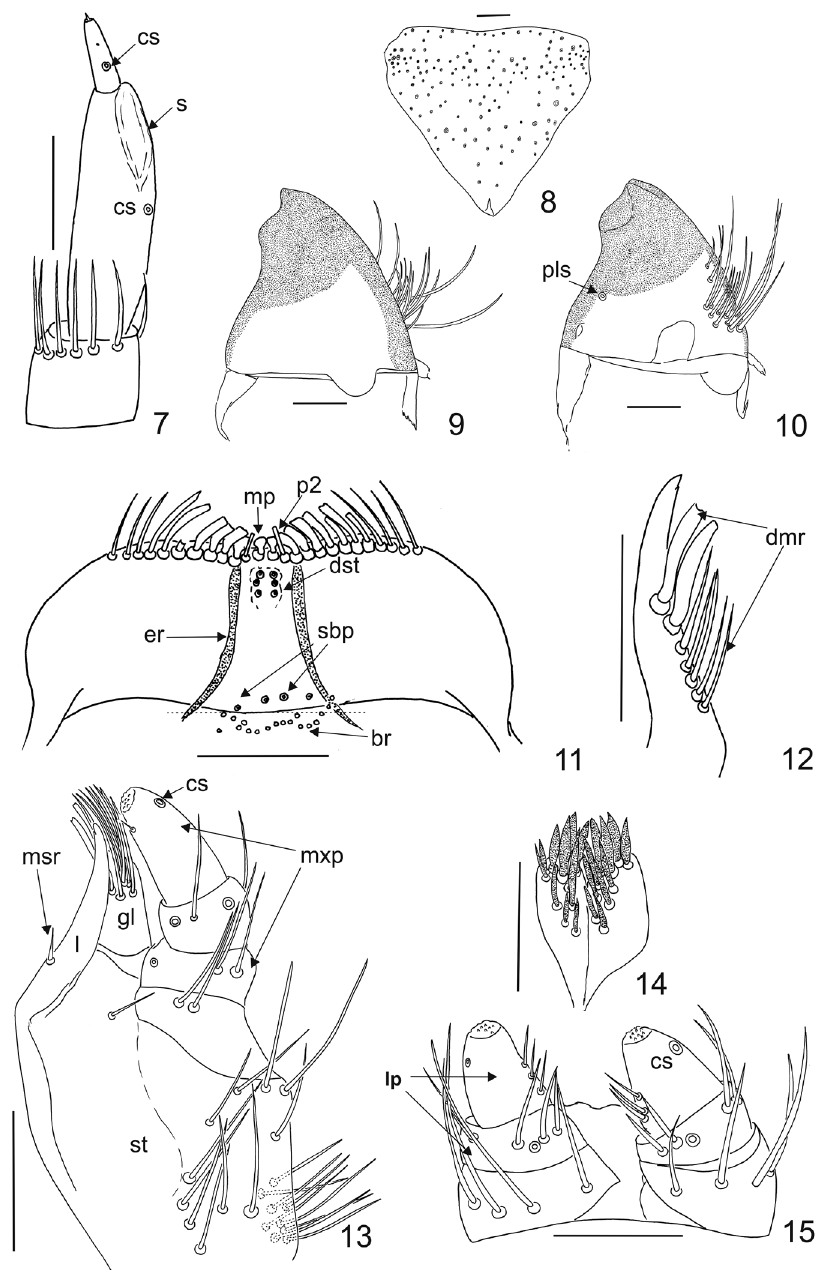
Figures 7–15. Mature larva of Ctesias (s. str.) serra (Fabricius, 1792). 7 Antenna (dorso-fronto-lateral) 8 Frons (dorsal; large circles with rings represent points of insertion of large scaly-like spicisetae, small circles represent points of insertion of nudisetae (= lanceolate spicisetae)) 9 Mandible (dorsal) 10 Man- dible (lateroventral) 11 Epipharynx (ventral) 12 Apex of lacinia (dorsal) 13 Maxilla (ventral) 14 Labium (ventral) 15 Labial palpi (ventral). Scale bars: 0.1